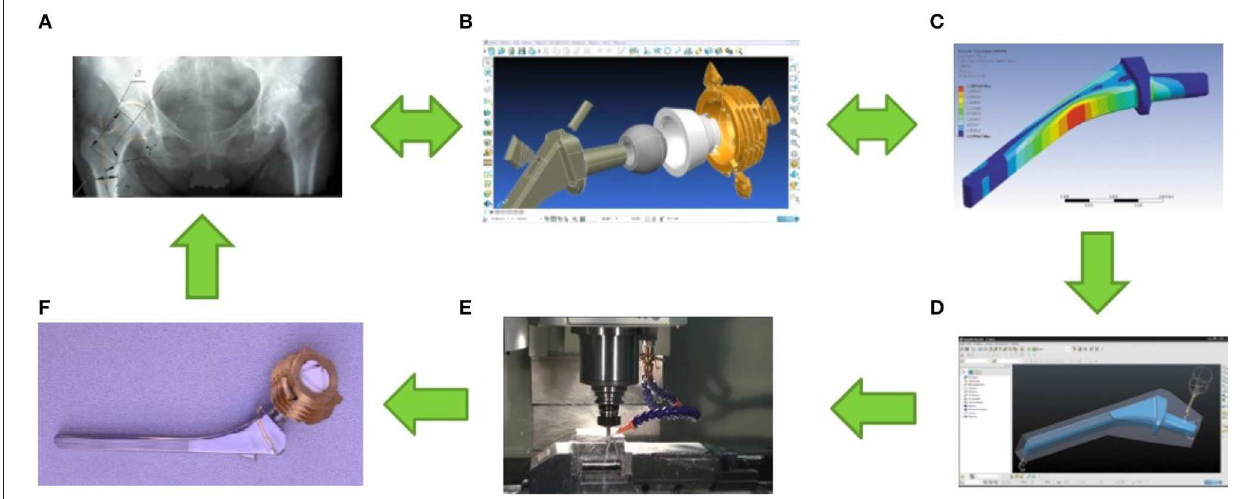
FIGURE 2 | Illustration of the stages of a personalized total hip arthroplasty. (A) The stage of diagnosis and decision-making on the treatment strategy for the disease. At this stage, the overall functional state of the patient, the nature, stage of the disease, condition and geometry of the bone structures in the vicinity of natural joint are evaluated. (B) The design phase. At this stage, the choice of biomaterial that is optimal for the manufacture of artificial joint elements and treatment of the disease in this physiological condition of the patient and his bone tissue is made; personalized artificial joint is being developed in accordance with natural joint geometry. (C) The stage of modeling and analysis of the functioning of artificial joint as part of a biotechnological system. At this stage, the stress-strain state of the artificial joint elements is assessed under extreme loads, taking into account the particular state of the bone structures of a particular patient; if necessary, changes are made to the design of artificial joint in order to increase the strength/stiffness of its elements. (D) Stage of development of manufacturing technology of artificial joint elements. At this stage, the dimensions and manufacturing technology of blanks for artificial joint elements are determined; the allowances necessary to achieve the required product quality are calculated; adjustments are made to the software of technological equipment for the manufacture of all elements of a personalized artificial joint. (E) Production phase of personalized artificial joint. At this stage, all artificial joint elements are manufactured and assembled; tests for compliance with mechanical and toxicological indicators are performed; sterilization of the product is in progress. (F) The stage of implantation of a personalized artificial joint. At this stage, artificial joint implantation is performed, the real state of the bone structures of a particular patient is assessed, and the postoperative procedures necessary for optimal integration of the implant into the bone structures are